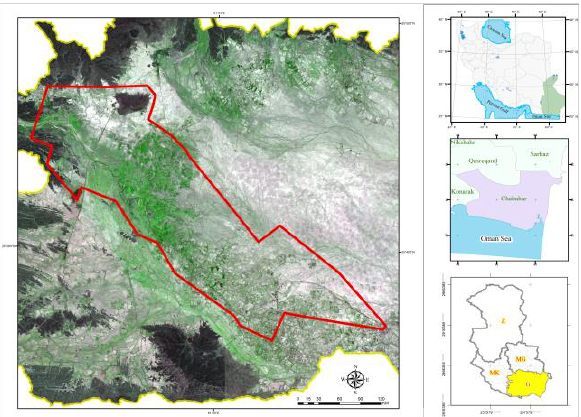
Figure 2. The location of the study